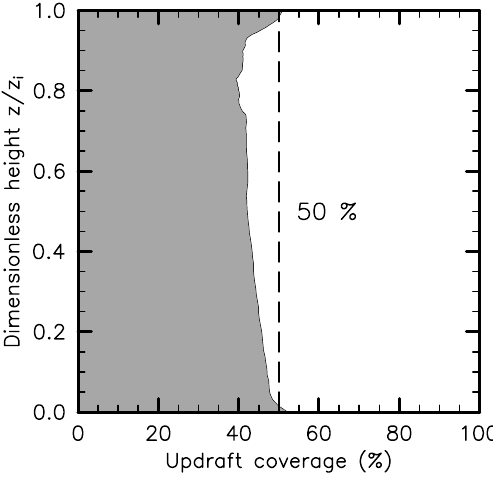
Fig. 4. Relative spatial coverage of updrafts as a function of z/z i , as computed from the surface occupied by positive values of the vertical